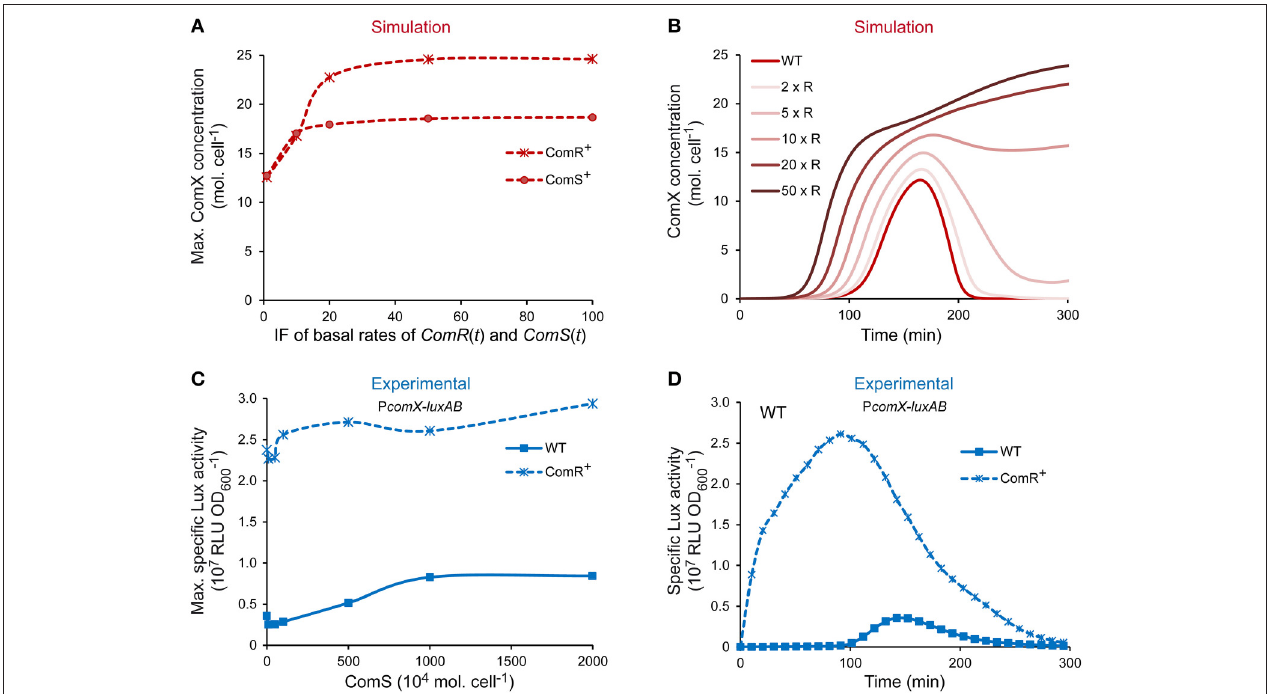
FIGURE 5 | Effect of ComR and ComS overproduction on the level and timing of competence development in strain LMD-9. (A) Maximum ComX concentration [molecules (mol.) cell − 1 ] computed by increasing the production rates of ComR and ComS. (B) Kinetics of ComX concentration (mol. cell − 1 ) computed by increasing the production rate of ComR. Production rates were increased by multiplying the maximal basal production rate of variables ComR ( t ) and ComS ( t ) by a constant inducing factor (IF). IF used in (A,B) are [1, 10, 20, 50, 100] and [1, 2, 5, 10, 20, 50] (IF R), respectively. (C) Comparison of the maximum specific luciferase × activity of CB001 reporter strains (P comX - luxAB ) containing either an empty control vector (CB001 [pMG36eT]; WT) or the constitutive comR overexpression vector (CB001 [pMGcomRstrep]; ComR + ) in response to increasing ComS 17 - 24 concentration. ComS 17 - 24 concentrations (nM) used are 0, 10, 50, 100, 500, 1000, and 2000. Nanomolar units were converted in 10 4 mol. cell − 1 (see legend of Figure 3 ). (D) Comparison of the kinetics of specific P comX activity in reporter strains containing either the comR overexpression vector (CB001 [pMGcomRstrep]; ComR + ) or a control vector (CB001 [pMG36eT]; WT) in absence of ComS 17 - 24 . In all experiments, strains were inoculated in CDML at an OD 600 of 0.05. Growth (OD 600 ) and luciferase activity (RLU) were directly monitored until strains reached the stationary phase. (C,D) The results of one representative experiment are